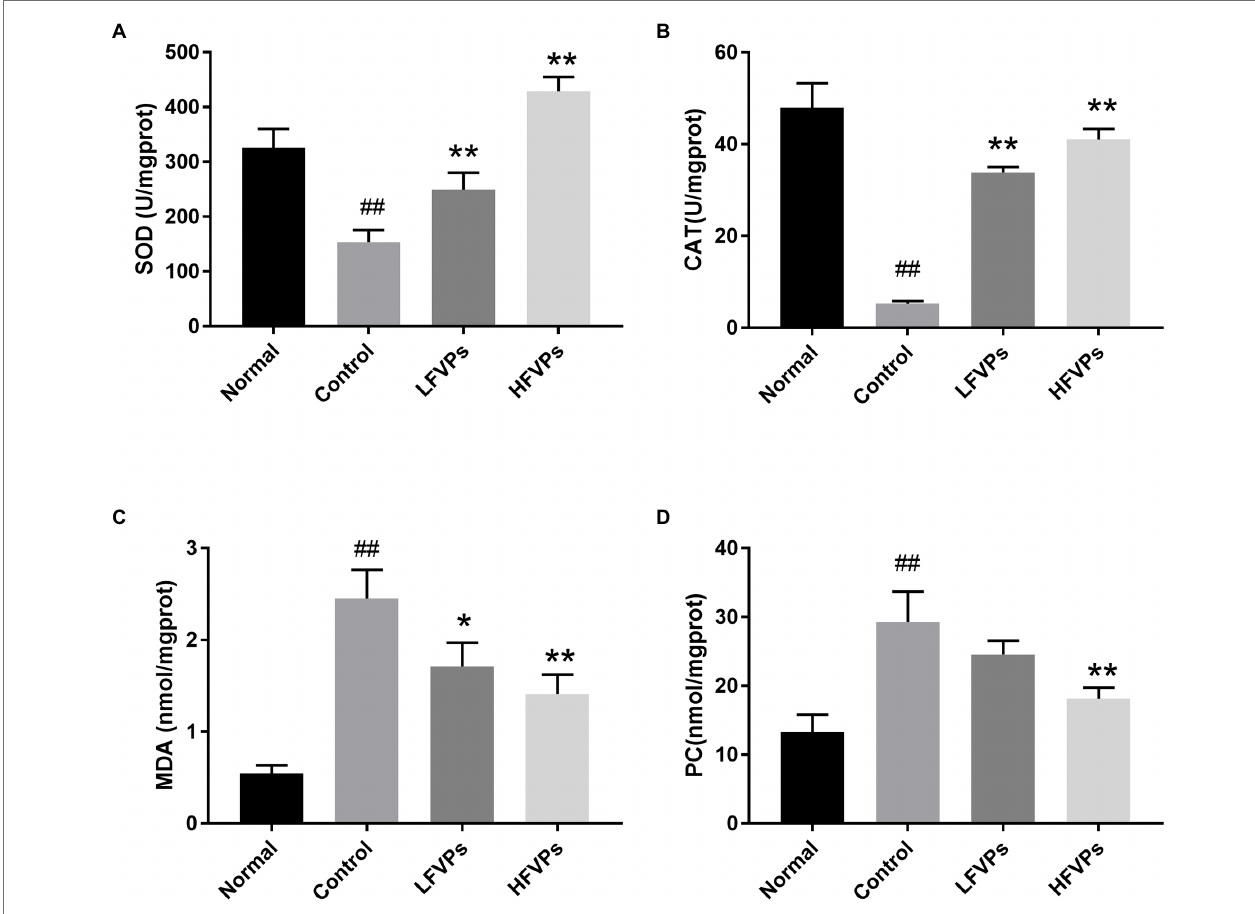
FIGURE 4 | Effect of FVPs on hepatic antioxidant activity. The bar charts show the results obtained for the hepatic content of (A) superoxide dismutase (SOD), (B) catalase (CAT), (C) malonaldehyde (MDA), and (D) protein carbonyl (PC; as measured using ELISA kits). The data are presented in the form: mean ± SD (with eight mice per group). The symbols # and ## represent significance levels of p < 0.05 and p < 0.01 compared to the Normal group, respectively. Similarly, * and ** represent p < 0.05 and p < 0.01 compared to the Control group,